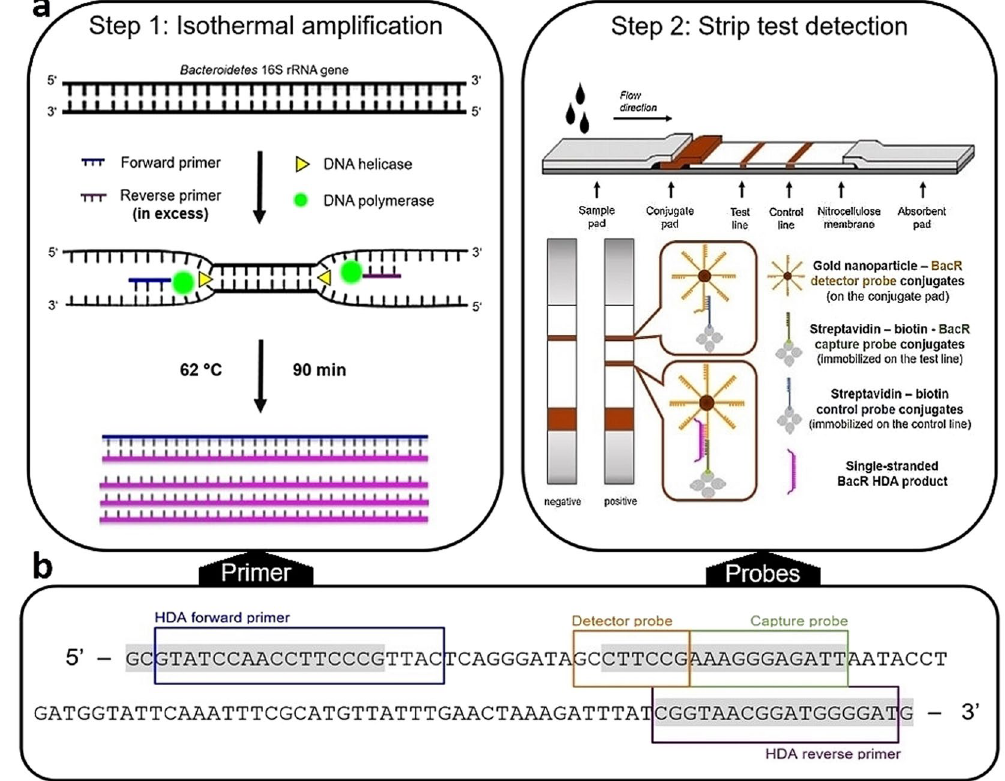
Figure 1. Schematic overview of the developed BacR HDA-strip assay ( a ) with incorporated HDA primer and strip test probe sequences ( b ). ( a ) (Step1) Asymmetric HDA amplification of the BacR marker on a heating block. (Step 2) Sequence-specific detection of HDA-derived single-stranded BacR marker copies via the nucleic acid lateral-flow strip test and visual readout of results. ( b ) Primer and probe binding sites of the HDA-strip and qPCR assay (GenBank accession number AF233400, bases 89 to 206). HDA primer and strip test probe regions (boxed) stretch over the qPCR primer and probe regions (marked in grey). The HDA amplicon is slightly shorter than the qPCR amplicon (115 bp versus 118